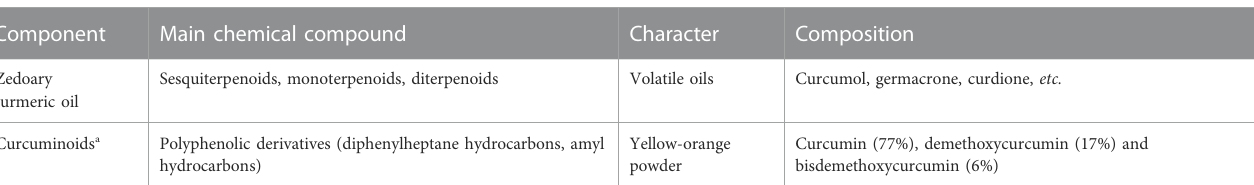
TABLE 1 Main active constituents of Curcumae